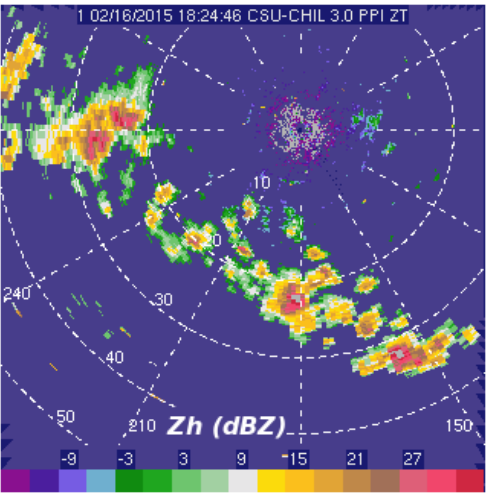
Figure 19. CSU-CHILL 3.0° elevation angle PPI horizontal reflectivity, Z h , data (in dBZ) at 18:24 UTC on 16 February 2015. These initial echoes developed approximately 10 km south of the MASCRAD Field Site and moved southward. Similar small convective echoes passed the Easton site approximately one hour later.